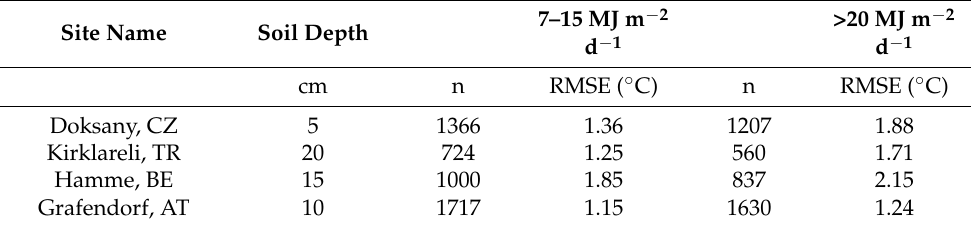
Table 5. Model performance (measured as RMSE, ◦ C) in response to daily solar radiation level